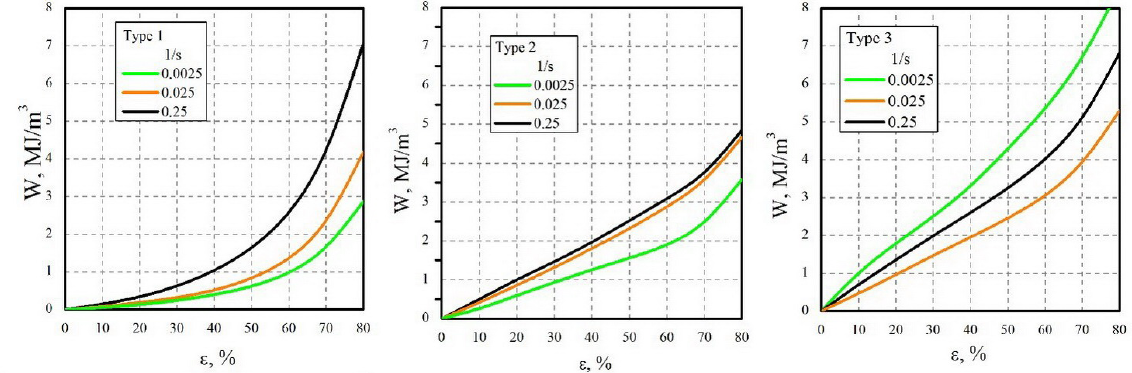
Figure 4: Specific energy absorption-strain curves of unreinforced (type 1), transverse reinforced (type 2), and longitudinal reinforced (type 3) foam samples for different strain